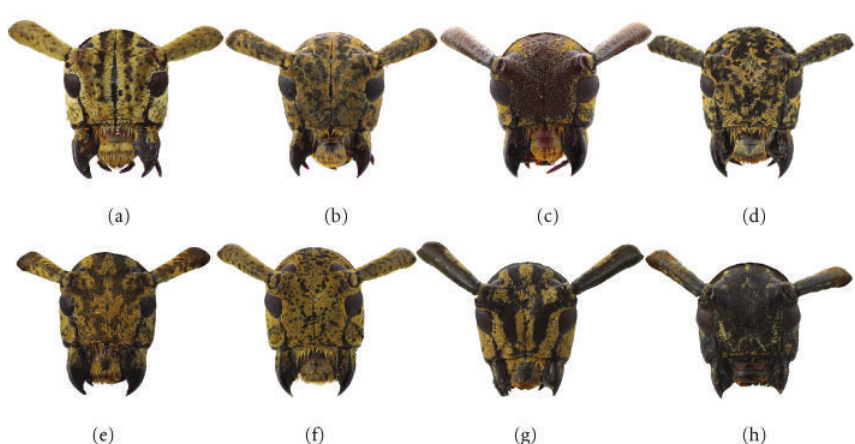
Figure 6: Male frontal view of Agelasta ( Dissosira ) spp. (a) A. ( D. ) catenata ; (b) A. ( D. ) perplexa ; (c) A. ( D. ) rufa ; (d) A. ( D. ) konoi ; (e) A.